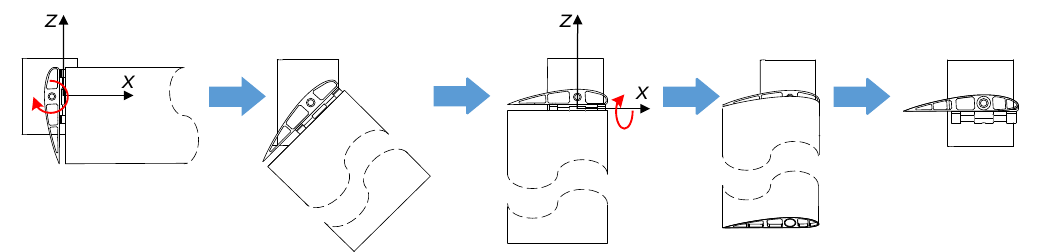
Figure 6. Folding wing deployment process (fixed-axis – non-fixed-axis stepwise deployment).